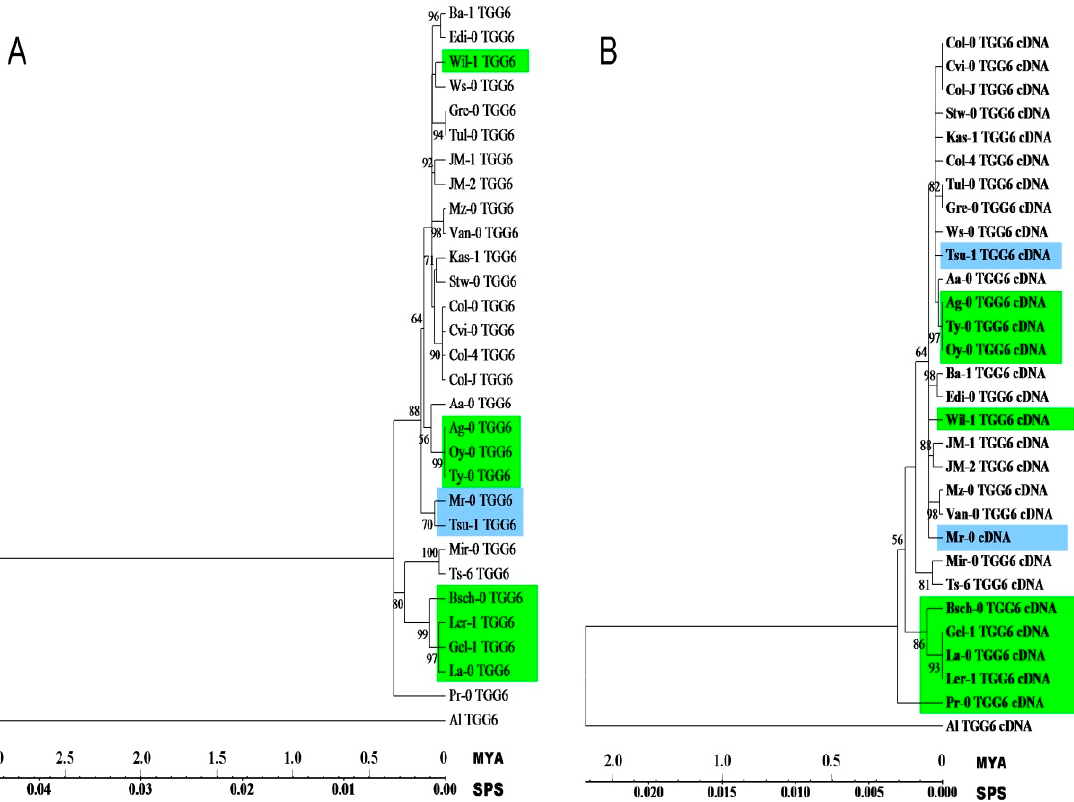
Figure 3. Phylogenetic analysis of AtTGG6 genomic ( A ) and cDNA ( B ) sequences by Maximum Likelihood method. The evolutionary history was inferred based on the Tamura–Nei model [23]. The bootstrap values over 50% are shown next to the branches. Initial tree(s) for the heuristic search were obtained automatically. The tree is drawn to scale, with branch lengths measured in million years (MYA) and substitutions per site (SPS). Evolutionary analyses were conducted in MEGA6 [24]. Functional alleles are highlighted in green or blue. The two functional alleles in Tsu-1 and Mr-0 which are clustered different in genomic and cDNA phylogenies are highlighted in blue.